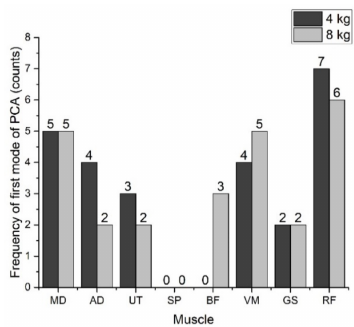
Figure 5. Principal muscles reviled by first mode of PCA for squat lifting for 4 and 8 kg weights. Medial deltoid (MD), anterior deltoid (AD), upper trapezius (UT), supraspinatus (SP), bicep femoris (BF) vastus laterals (VS), gastrocnemius (GS), and rectus femoris (RF).